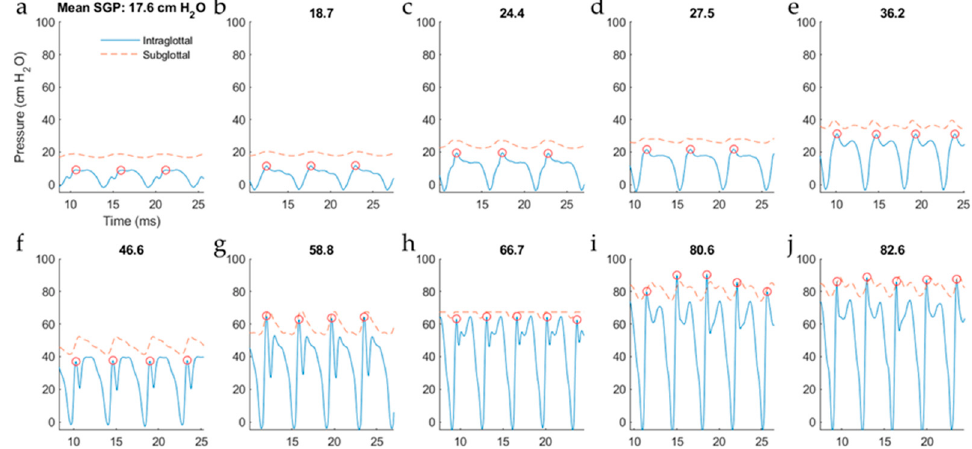
Figure 10. Effect of increases in mean subglottal pressure (SGP) while the intraglottal sensor position is maintained in the phonatory strike zone. Intraglottal and subglottal pressure signals are displayed for the reported mean subglottal pressures that increase from 17.6 cm H 2 O to 82.6 cm H 2 O for subfigures ( a – j ). Instants of peak collision pressure per cycle (red circles) are indicated in each subfigure.